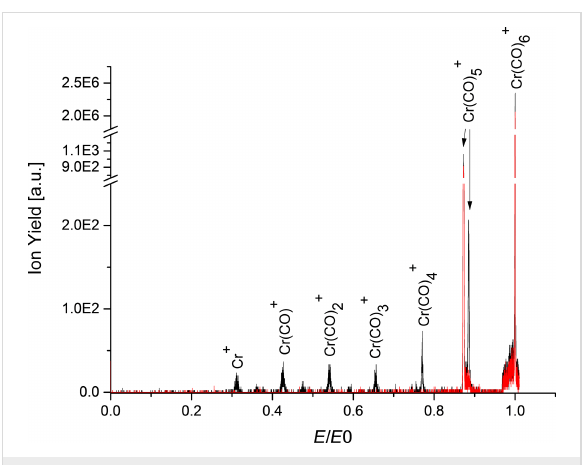
Figure 4: Electric sector field scan transmitting the Cr(CO) 6+ precur- sor ion at the electric field E 0 without collision gas (red curve) and with collision gas (black) in the collision cell. The fragment ions formed in the collision cell were subsequently accelerated with 600 V. Without collision gas only the metastable decay of the parent cation into Cr(CO) 5+ , in the FF2 was detected; in the collision-induced dissocia- tion spectrum several more peaks appear (see text). The metastable peak is still present in this case. The initial electron energy was ca. 70